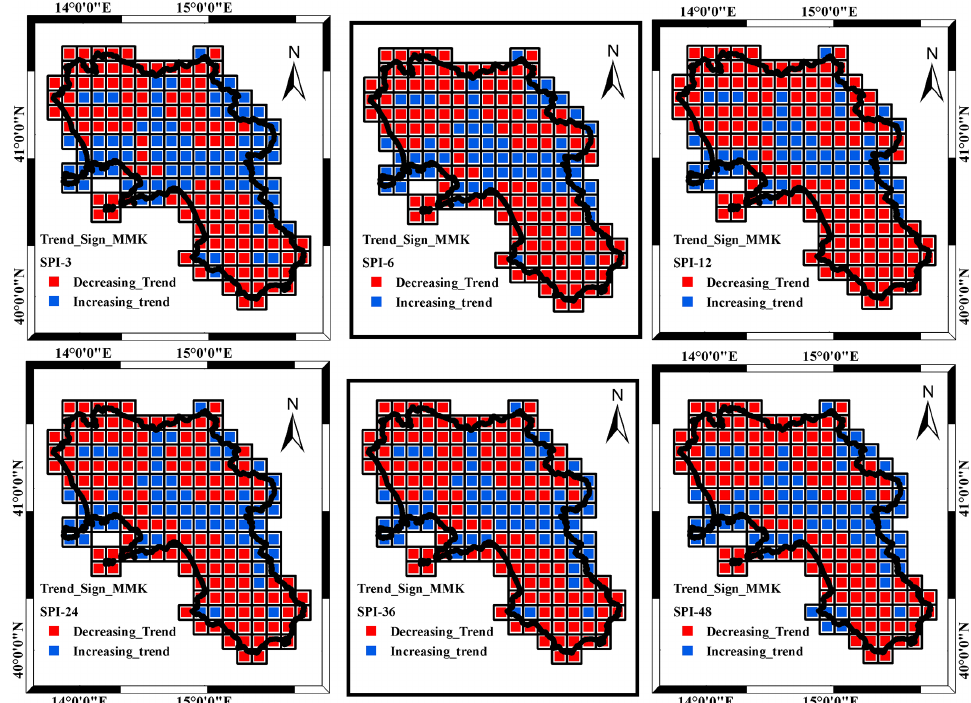
Figure 4. SPI MMK test sign for the different accumulation scales ( α = 5%).